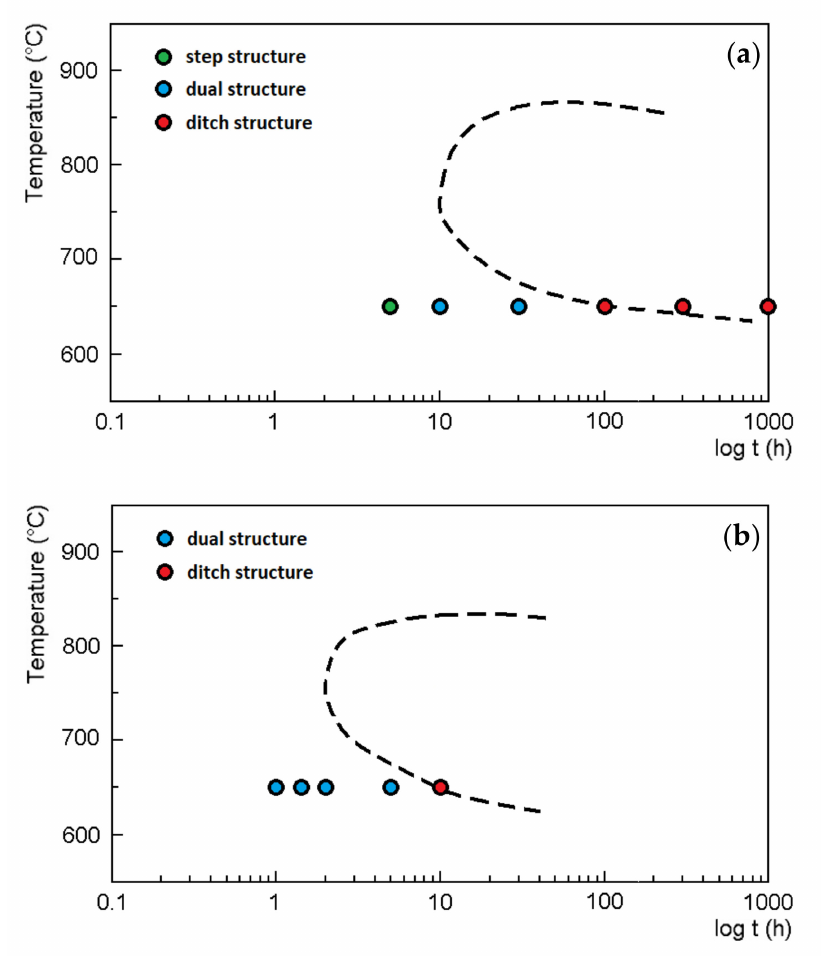
Figure 2. TTS diagrams of AISI 316L: ( a ) AISI 316L (0% CW); ( b ) AISI 316L (40%